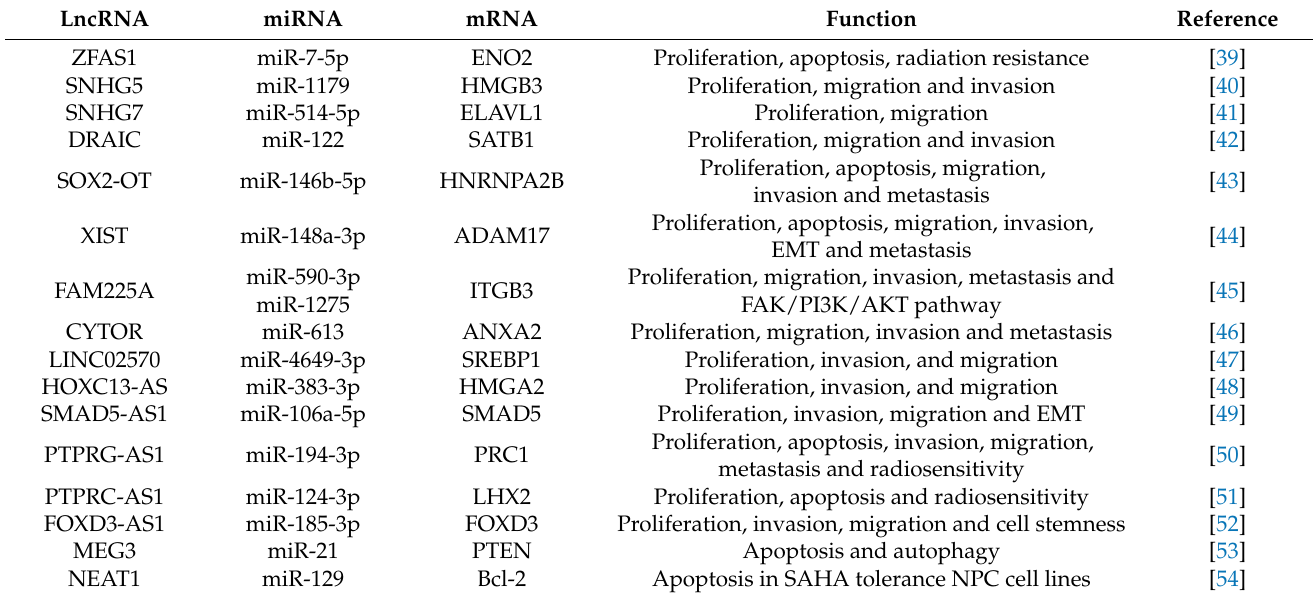
Table 1. CeRNA networks of lncRNA-miRNA-mRNA involved in NPC proliferation and apoptosis.